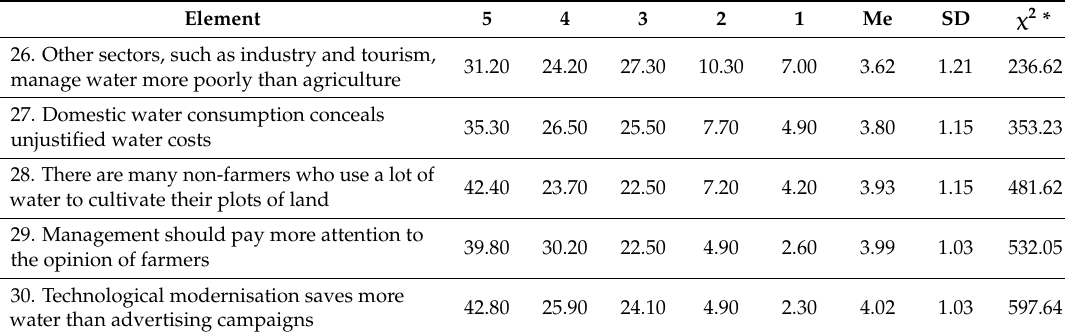
Table 4. Results of the appellative